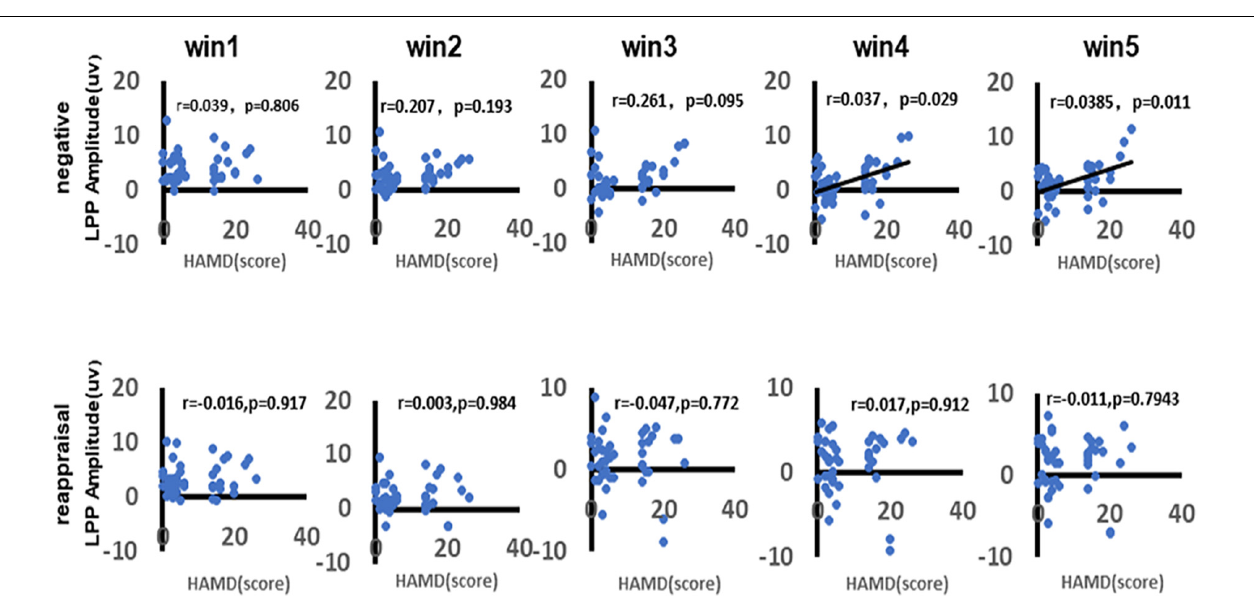
FIGURE 8 | Correlation between depression and LPP amplitudes. As shown in figure, the first row demonstrates the correlation between depression and LPP amplitudes in response to negative stimuli of different time windows (win1, win2, win3, win4, and win5). The second row demonstrates the correlation between depression and LPP amplitudes in response to reappraisal stimuli of different time windows (win1, win2, win3, win4, and win5). Only the significant correlation would show a trend